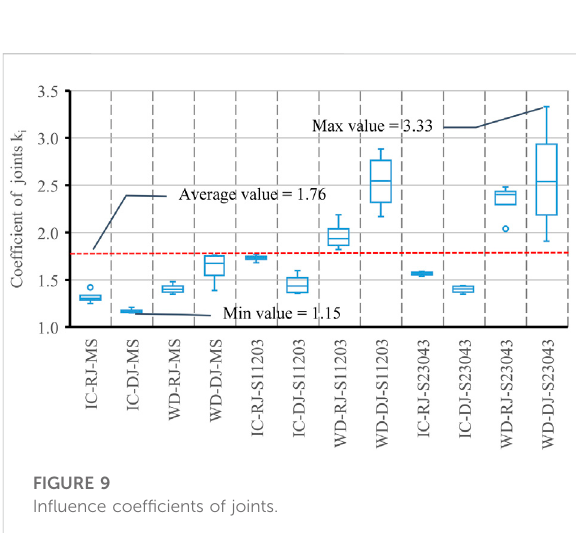
In fl uence coef fi cients of joints.